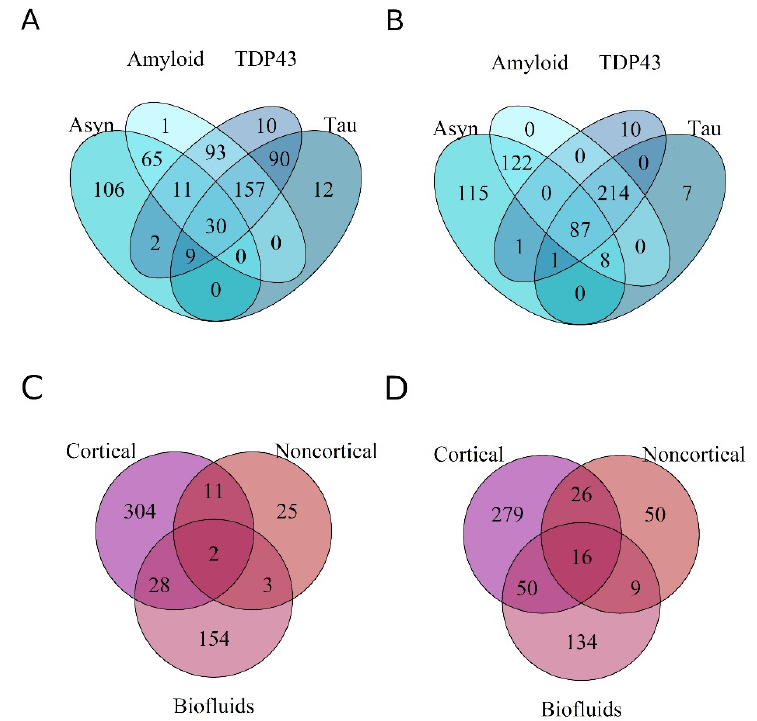
Figure 4. Venn diagrams representing the overlap of miRNAs differentially expressed within a proteinopathy ( A , B ), and in a specific anatomical region or biofluid ( C , D ). ( A , C ) demonstrate upregulated miRNAs, while ( B , D ) demonstrate downregulated miRNAs. Few miRNAs were unique to each proteinopathy and anatomy. 15% and 5% of DE miRNAs were commonly down- and upregulated, respectively, between all protein pathologies. Less than 5% of DE miRNAs obtained from the expression profiles were commonly DE in both brain material and biofluids.